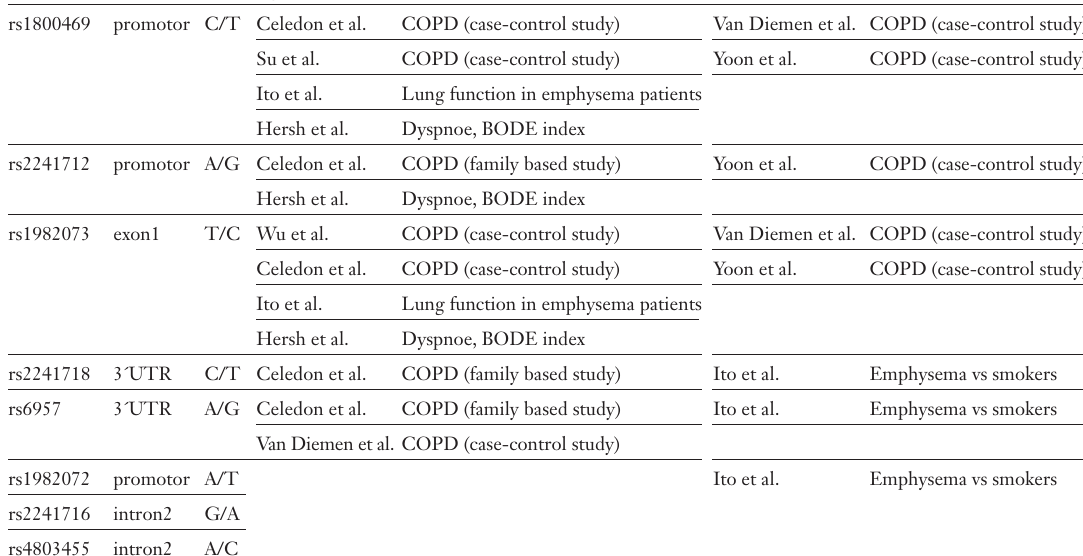
Table 2 TGF- β 1 gene single nucleotide polymor- phisms in